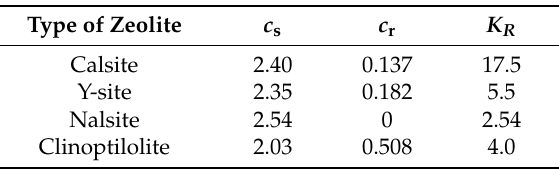
Table 5. Effective distribution coefficients calculated for various types of sorbents in the concentration of cupric cations of 2.54 g · dm − 3 .